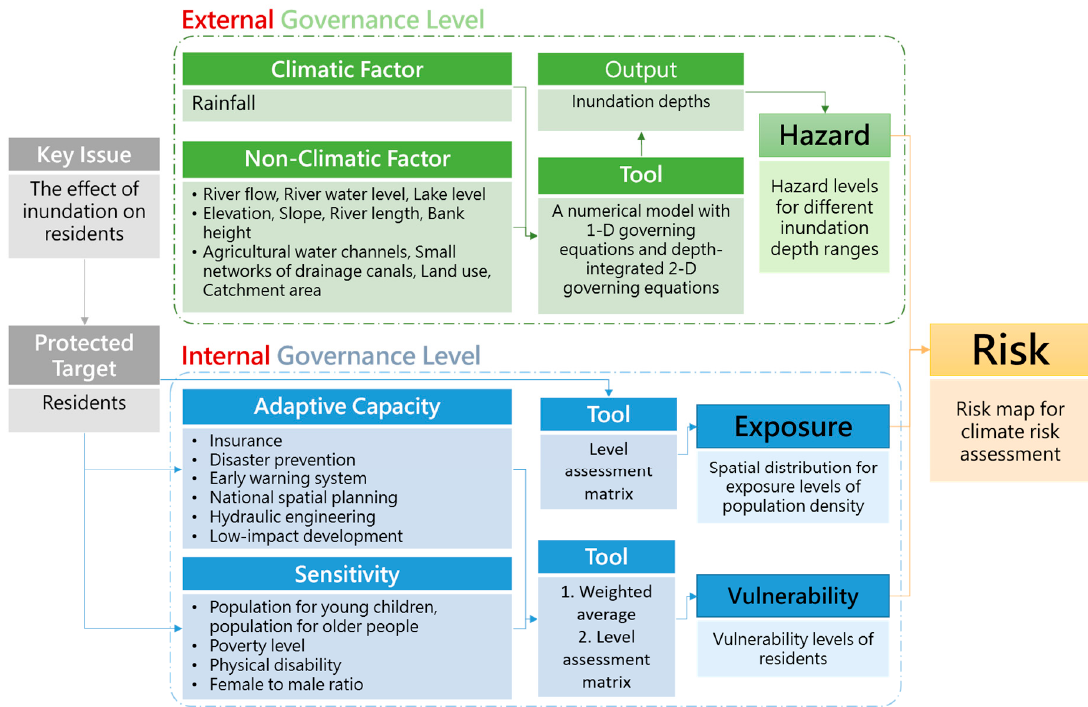
Figure 8. The possible causes of climate risk in flood disaster and the possible adaptation strategies.